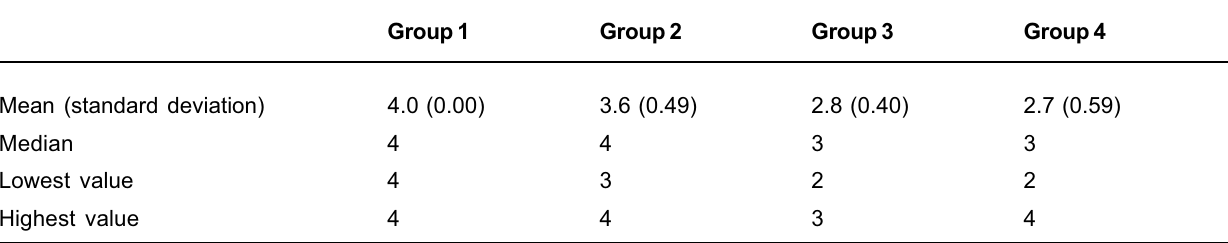
TABLE 1- Halitosis scores recorded in each